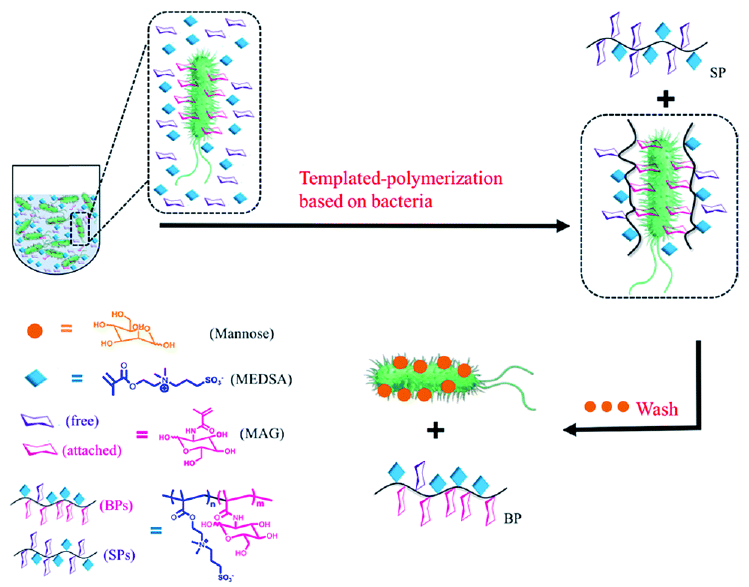
Figure 10. Two different polymers are obtained by polymerization using bacteria as living templates: (1) in solution (SP), (2) on the bacterial surface (BP) [52].